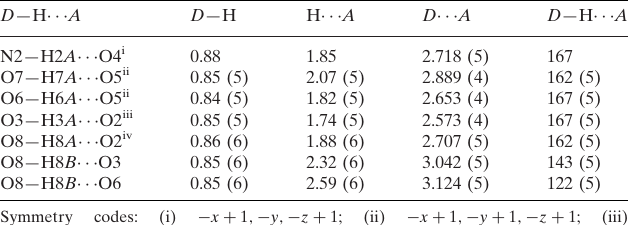
Hydrogen-bond geometry (A˚ , (cid:4)